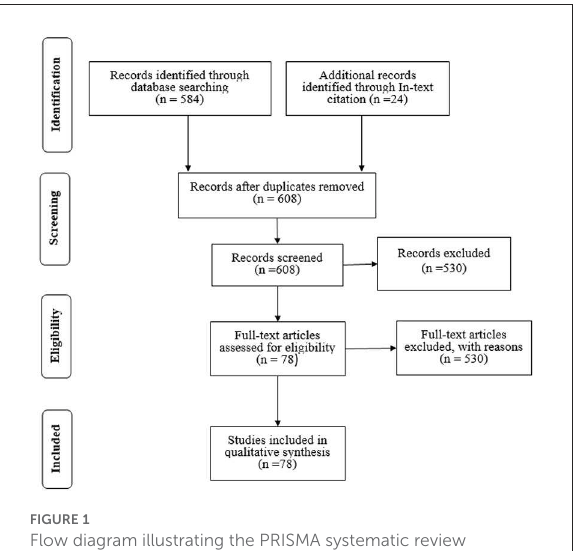
FIGURE1 Flow diagram illustrating the PRISMA systematic review exclusion process and the number of sources identified, included, or excluded at each stage of the analysis (Moher et al.,